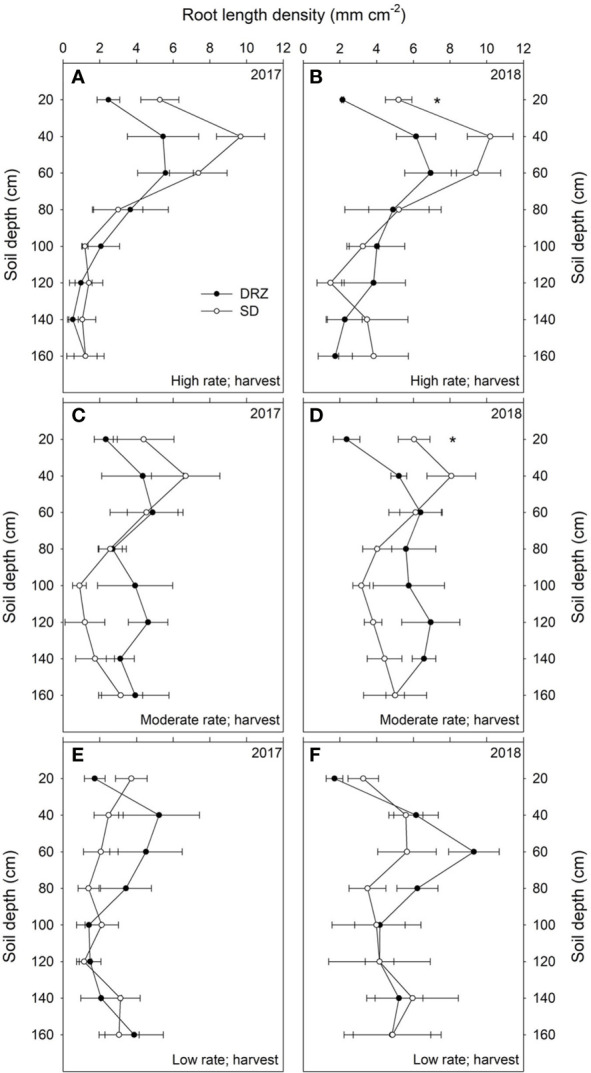
Root length density (RLD, mm cm−2) along the 0–160 cm soil profile under surface drip (SD, open circles) and direct root-zone (DRZ, closed circles) irrigation at harvest in 2017 and 2018. Three irrigation rates were set based on crop evapotranspiration (ETc) for Cabernet Sauvignon: (A, B) high rate: 0.75–0.80 ETc; (C, D) moderate rate: 0.60–0.65 ETc; and (E, F) low rate: 0.45–0.50 ETc. * represents statistical differences at P < 0.05, 0.01 and 0.001, respectively. Error bars represent standard error (n = 3).